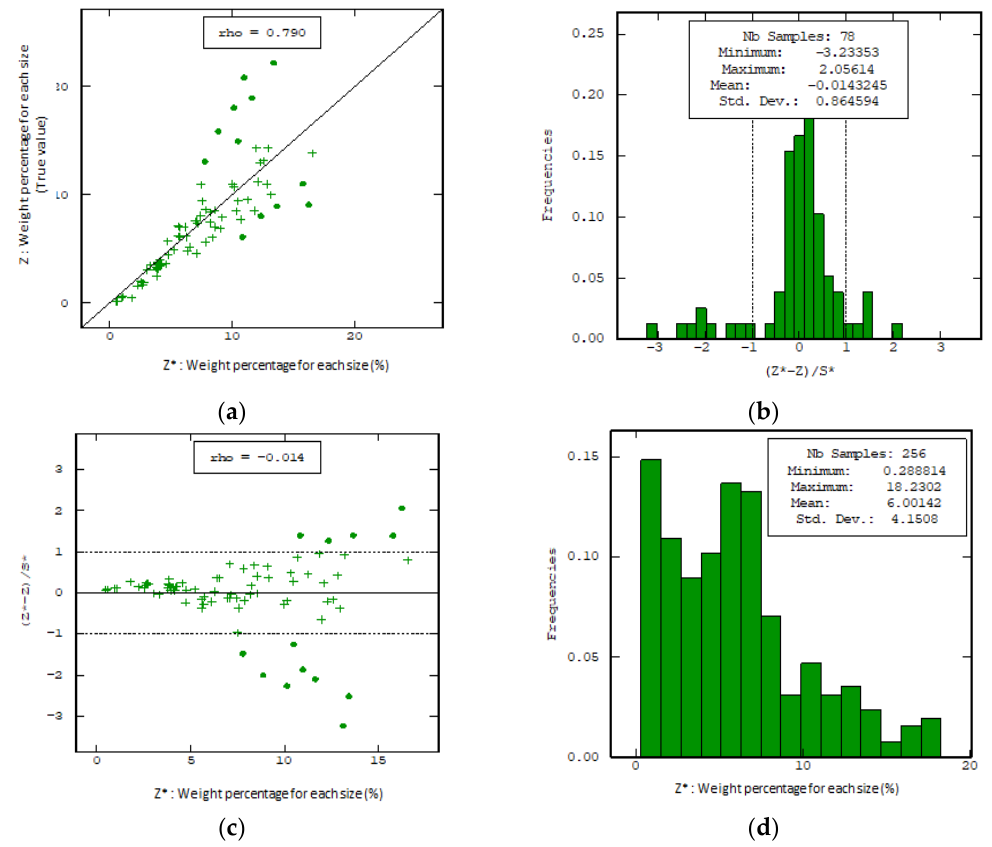
Figure A8. Cross-evaluation of the geostatistical analysis of LGP-3 with ore-B. ( a ) Scatter plot (identity line) where the x-axis represents modeled data, and the y-axis represents the experimental data. ( b ) Standardized error histogram. ( c ) Standardized error based on the estimated value. ( d ) Histogram and its statistical parameters of the estimated data.